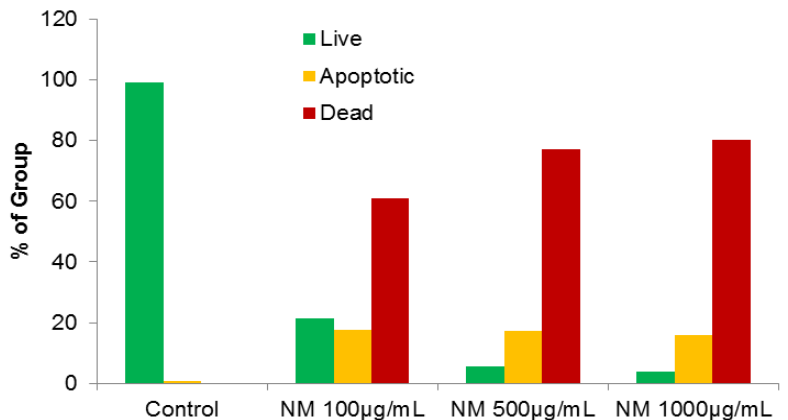
Figure 9. Effect of NM on HepG2 apoptosis: quantitative